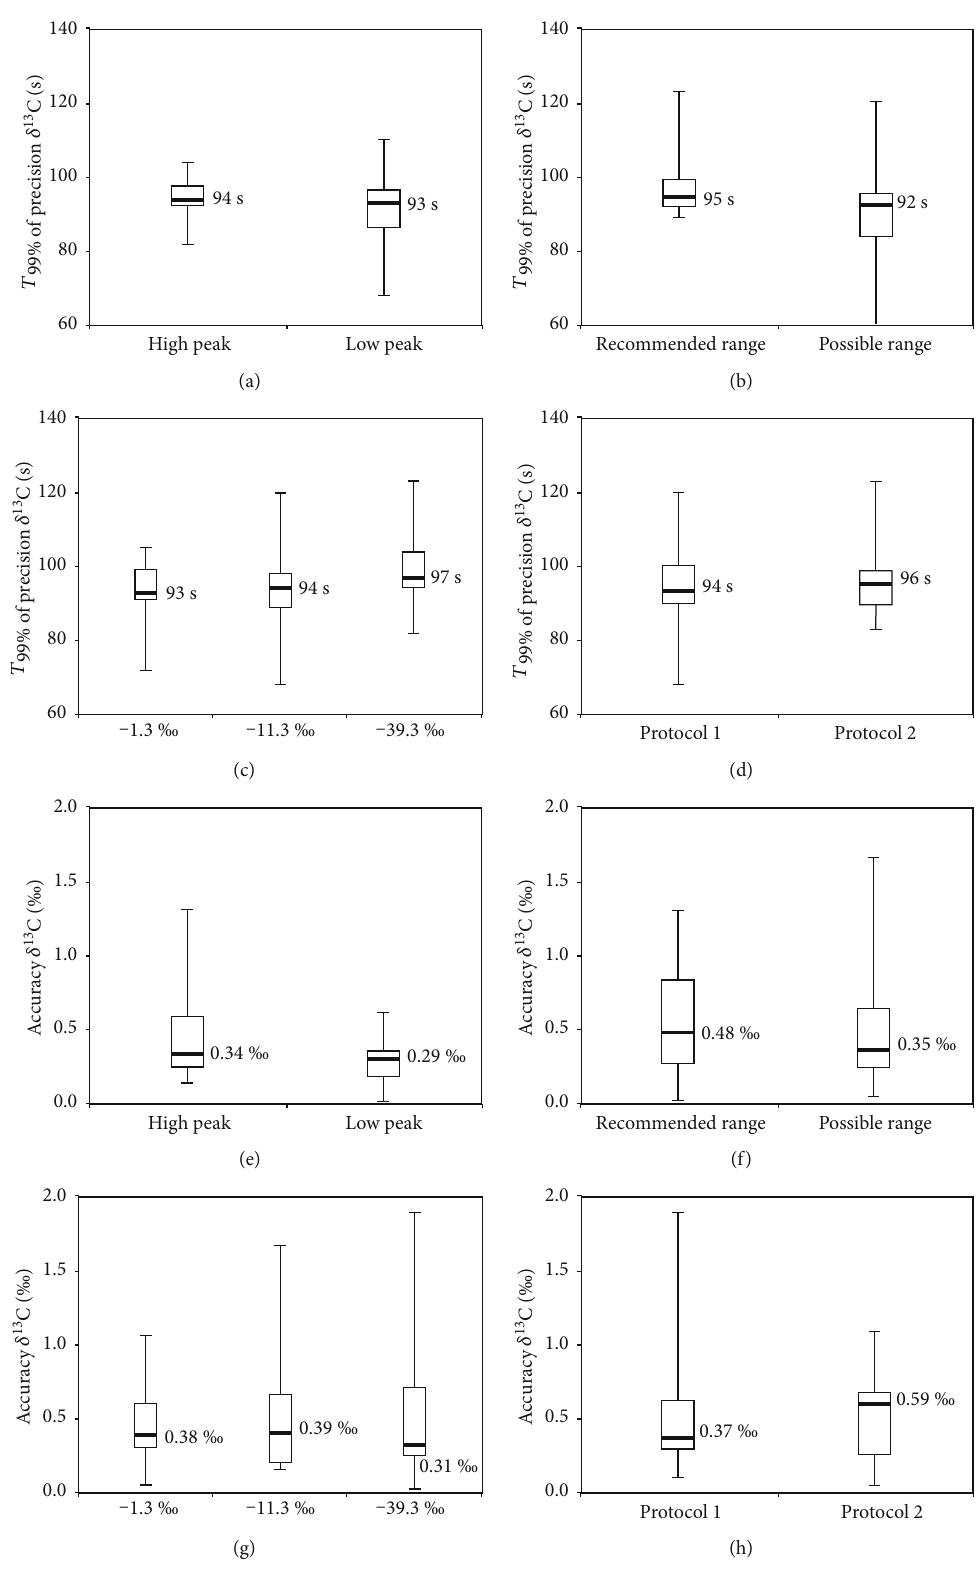
Figure 4: Box-and-whisker plots for (a – d) the time required to reach 99% of the maximum precision and (e – h) the accuracy of δ 13 C. Precision and accuracy are studied in function of the peak integration (a, e), the range of use of the dilution tube (b, f), the isotopic signature of the reference gas (c, g), and the kind of protocol applied for the fl ushing and reference analysis time (d, h). Details provided in the text and in